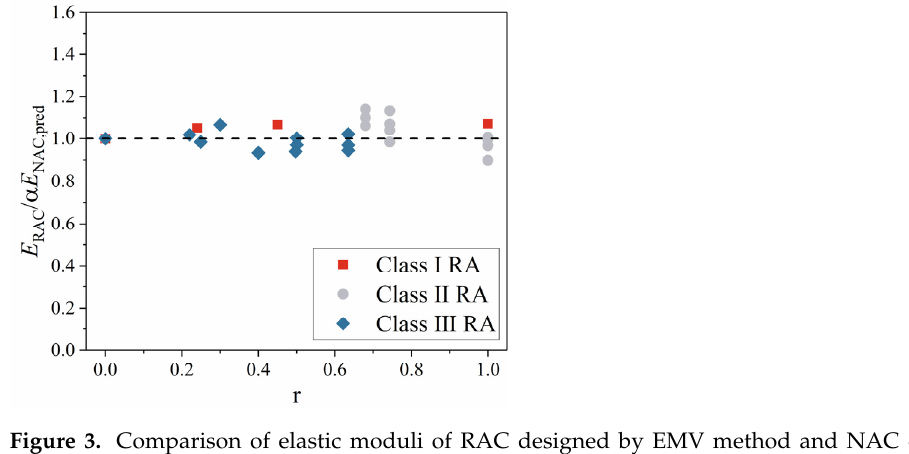
Figure 3. Comparison of elastic moduli of RAC designed by EMV method and NAC of equal strength [86,93,101,111,115,120,126,168].